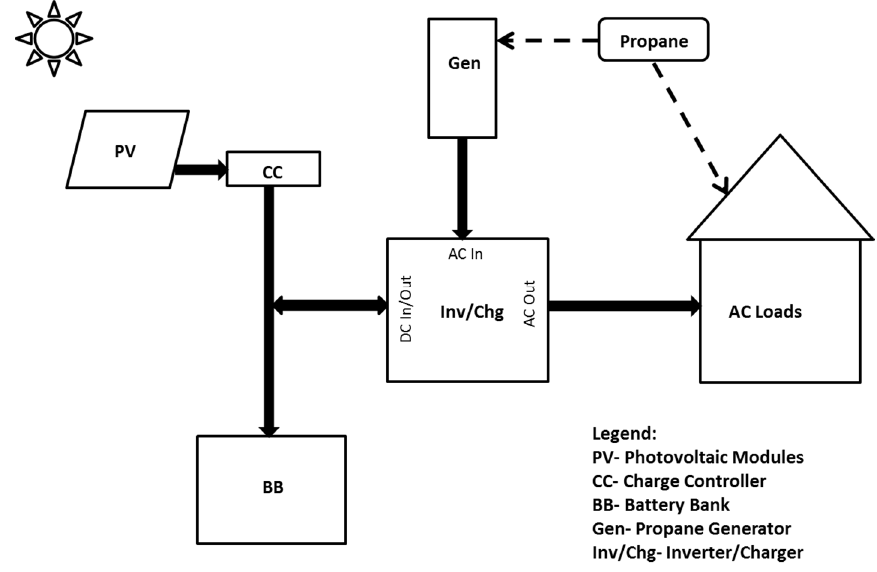
Figure 1. Typical off-grid, hybrid residential electrical power